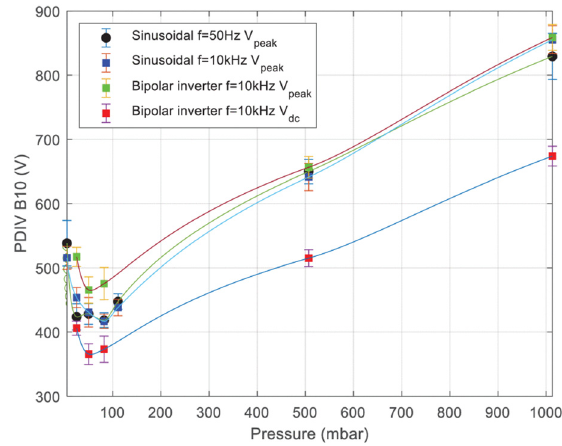
Figure 12. PDIV under different pressure [138].